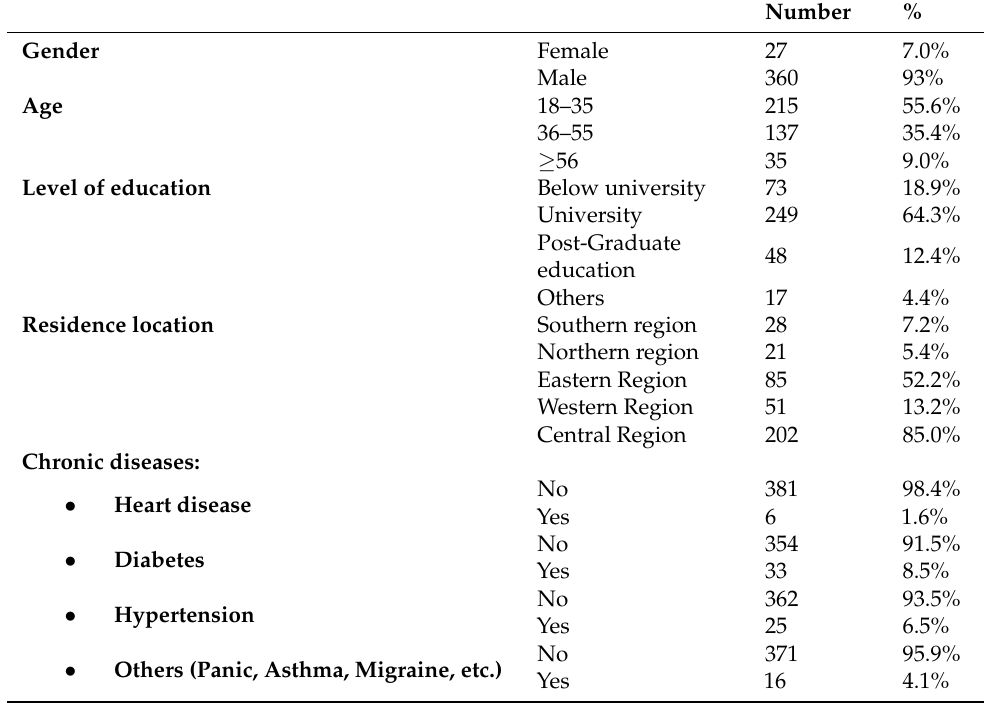
Table 2. Characteristics of the Saudi day trader sample (N =